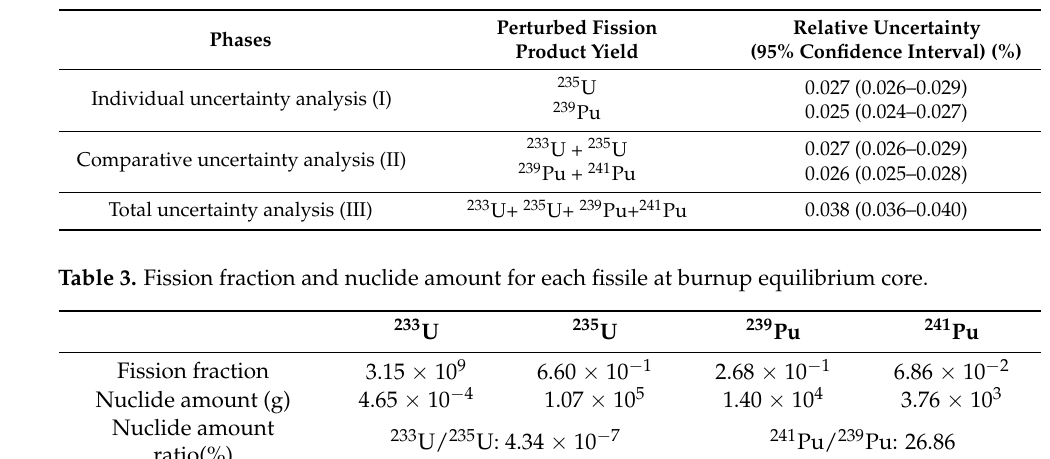
Table 2. k eff UQ results of equilibrium core.